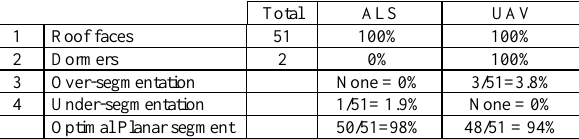
Table 4. Comparison of optimal segmentation